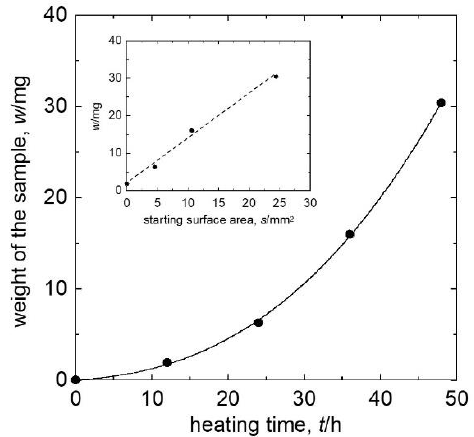
Figure 3. Weight of the seeded grown type-II Na–Si clathrate crystal plotted against the total heating time. The insert shows the relationship between the weight and surface area of the seed crystal.